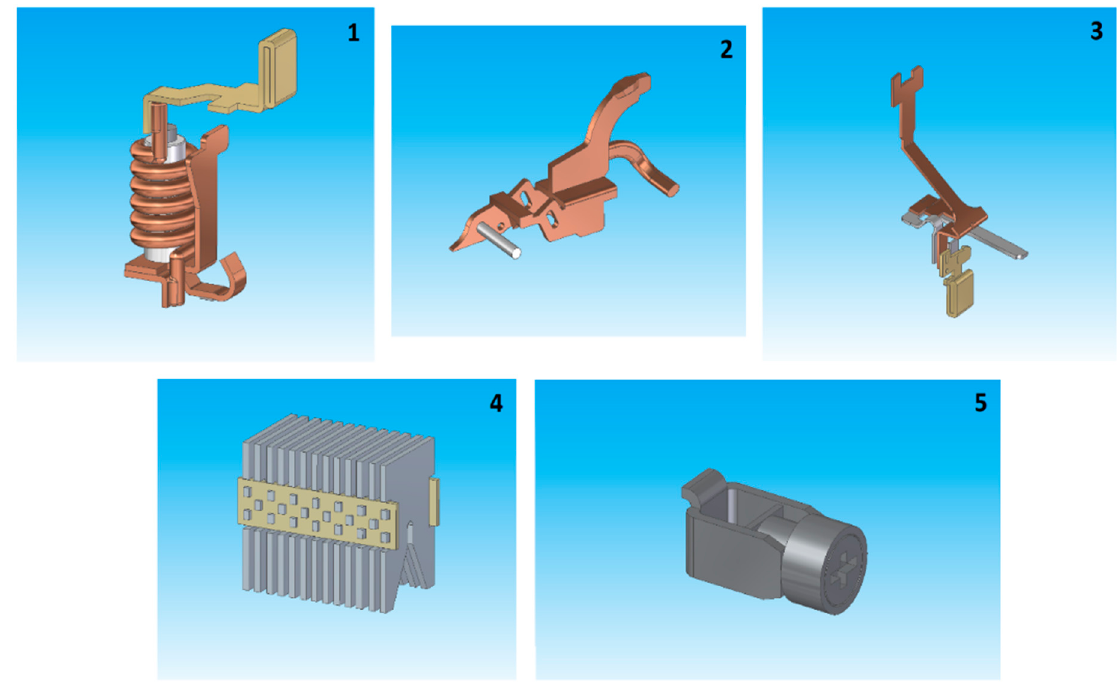
Figure 8. The main elements of the tested circuit breakers current path drawn in 3D.